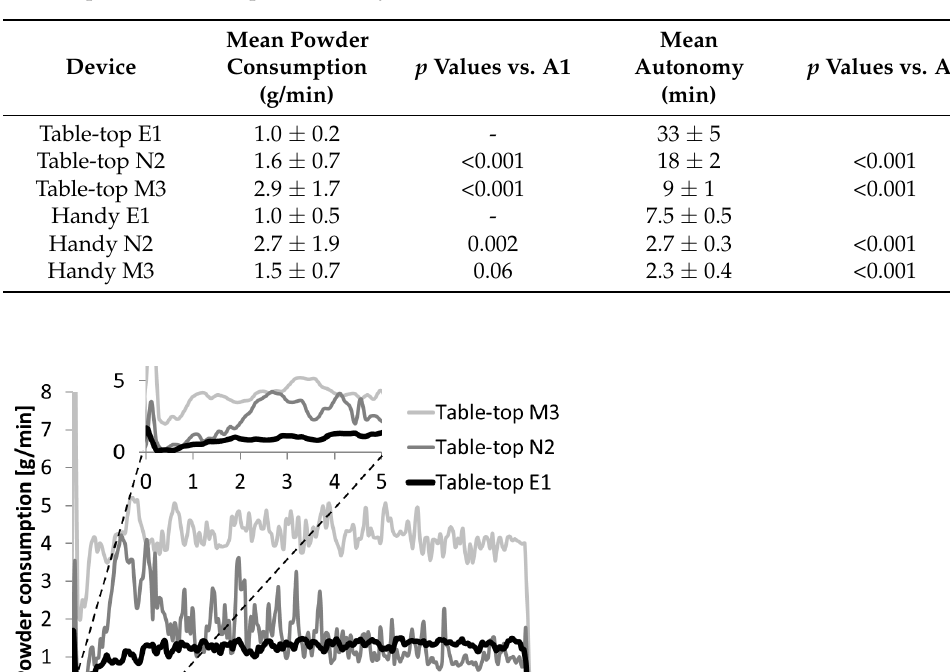
Figure 3. Powder consumption until complete powder chamber emptying. Only the effective device working time is shown. Table 2. Powder consumption and autonomy: the statistical differences are compared between Table-Top E1 for Table-tops and Handy E1 for Handies.